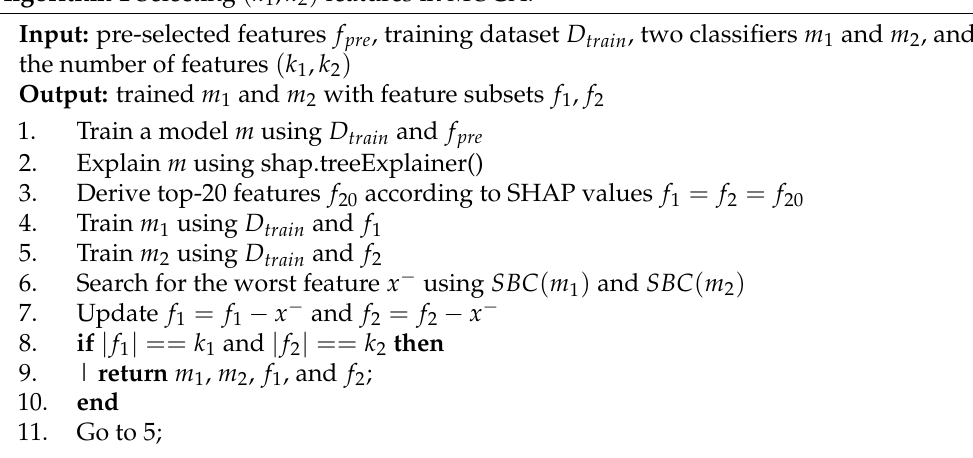
Algorithm 1 Selecting ( k 1 , k 2 ) features in